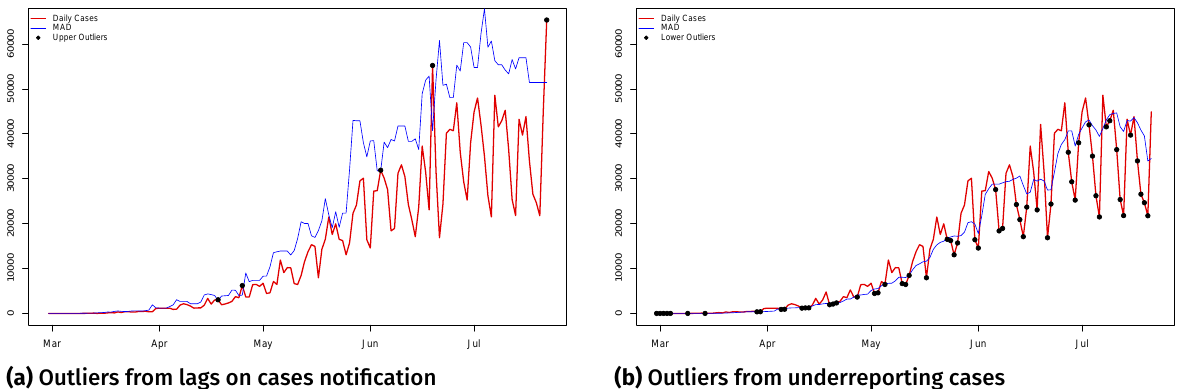
Figure 12. Outliers identification in data of COVID daily cases in Brazil using the Median Absolute Deviation (MAD).